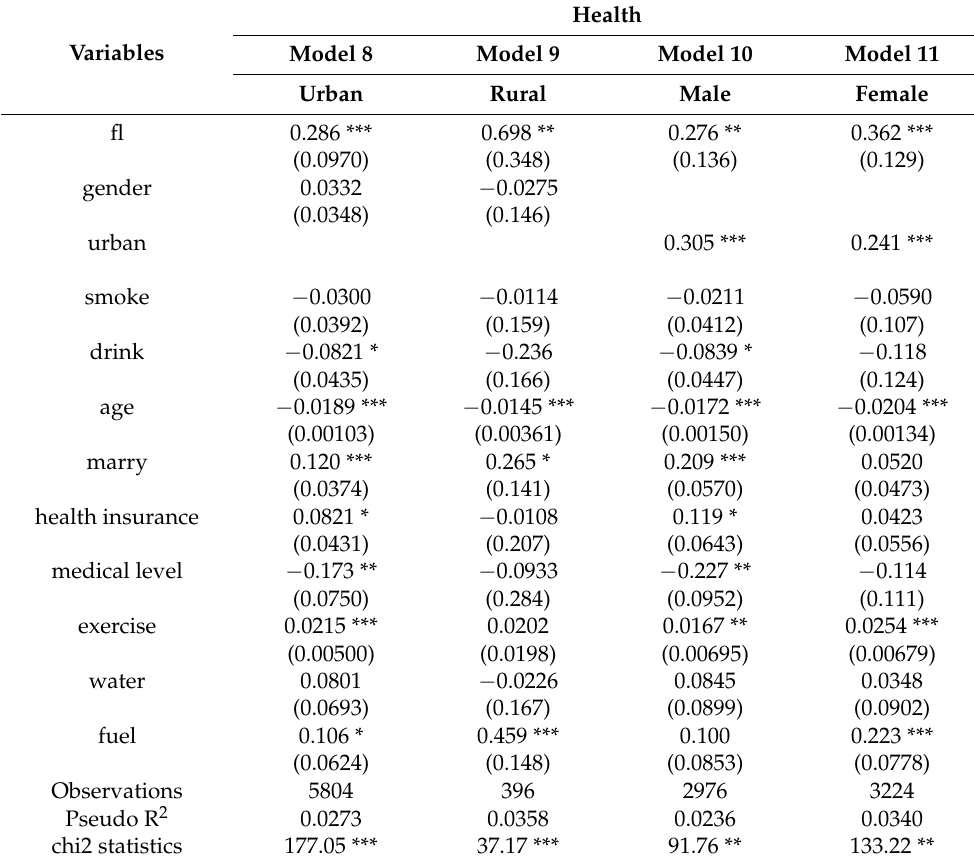
Table 6. Results of the heterogeneity